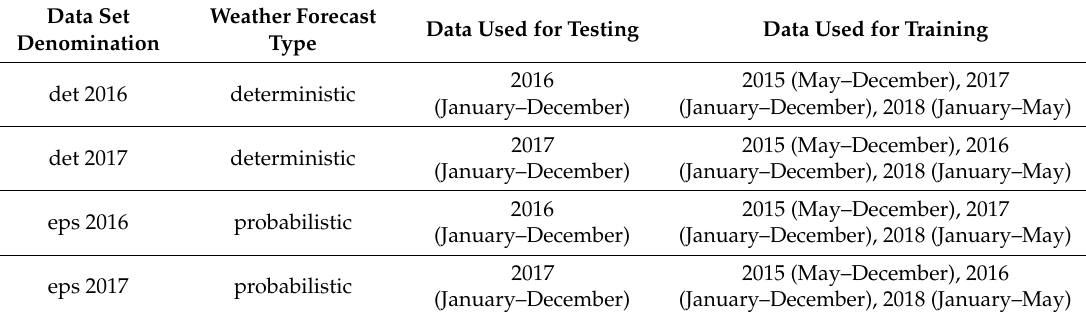
Table 2. Data sets used for the ALFRED application analysis.